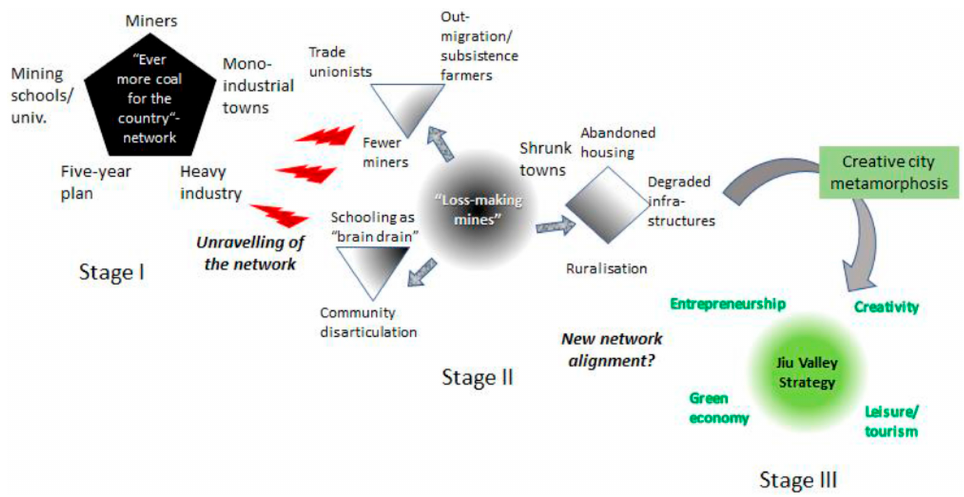
Figure 14. Stages of strategizing the development of Jiu Valley territory (Romania) after ending coal mining activity (Reprinted from Ref. [140]).